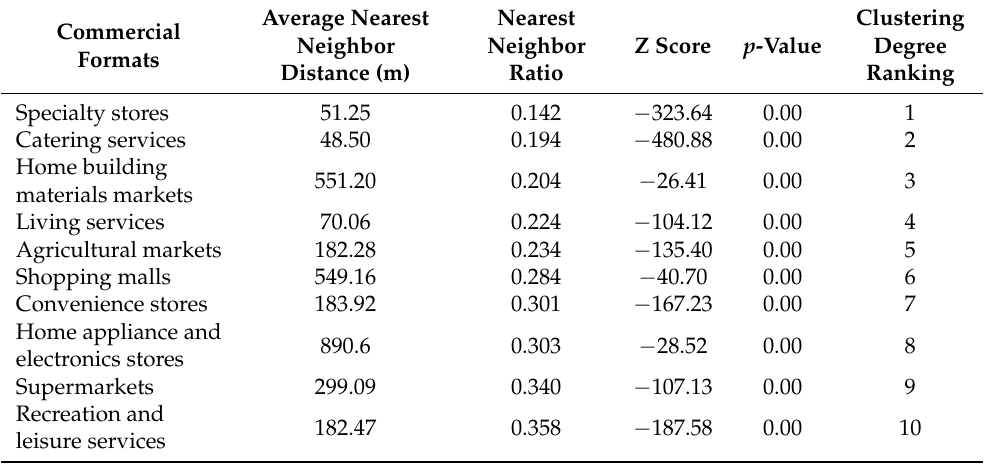
Table 3. Average nearest neighbor analysis of commercial spaces in